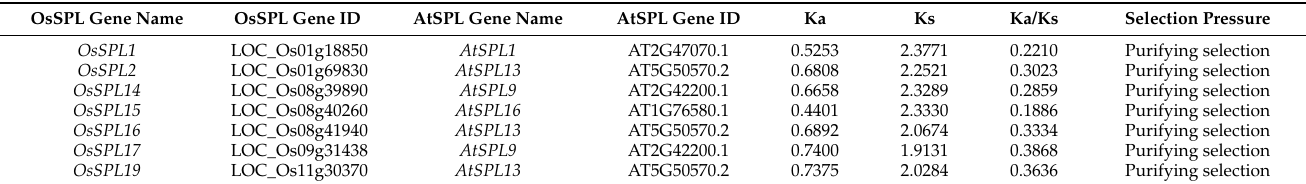
Table 3. One to one orthologous relationships between the SPL gene members of Oryza sativa and Arabidopsis thaliana